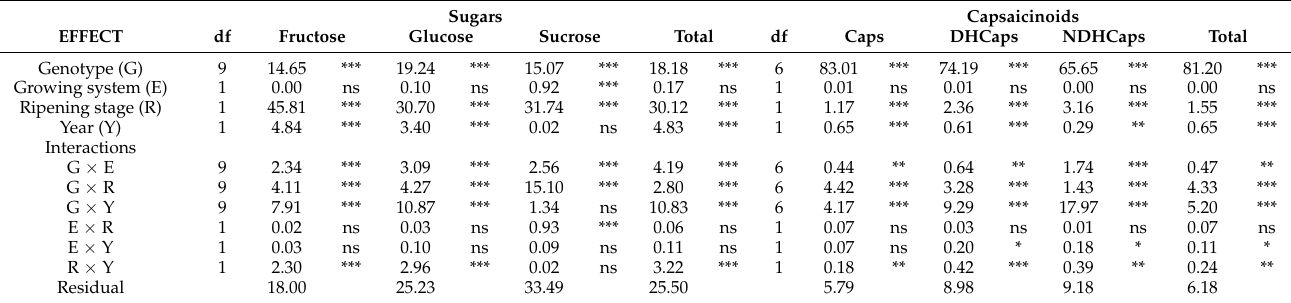
Table 1. ANOVA’s total sum of squares (expressed in %) for the effects the genotype (G), growing system (E), ripening stage (R), and year (Y), and their interactions for the content in sugars: fructose, glucose, sucrose and total sugars, and capsaicinoids: capsaicin (Caps), dihydrocapsaicin (DHCaps), nordihydrocapsaicin (NDHCaps), and total capsaicinoids. Sugars Capsaicinoids